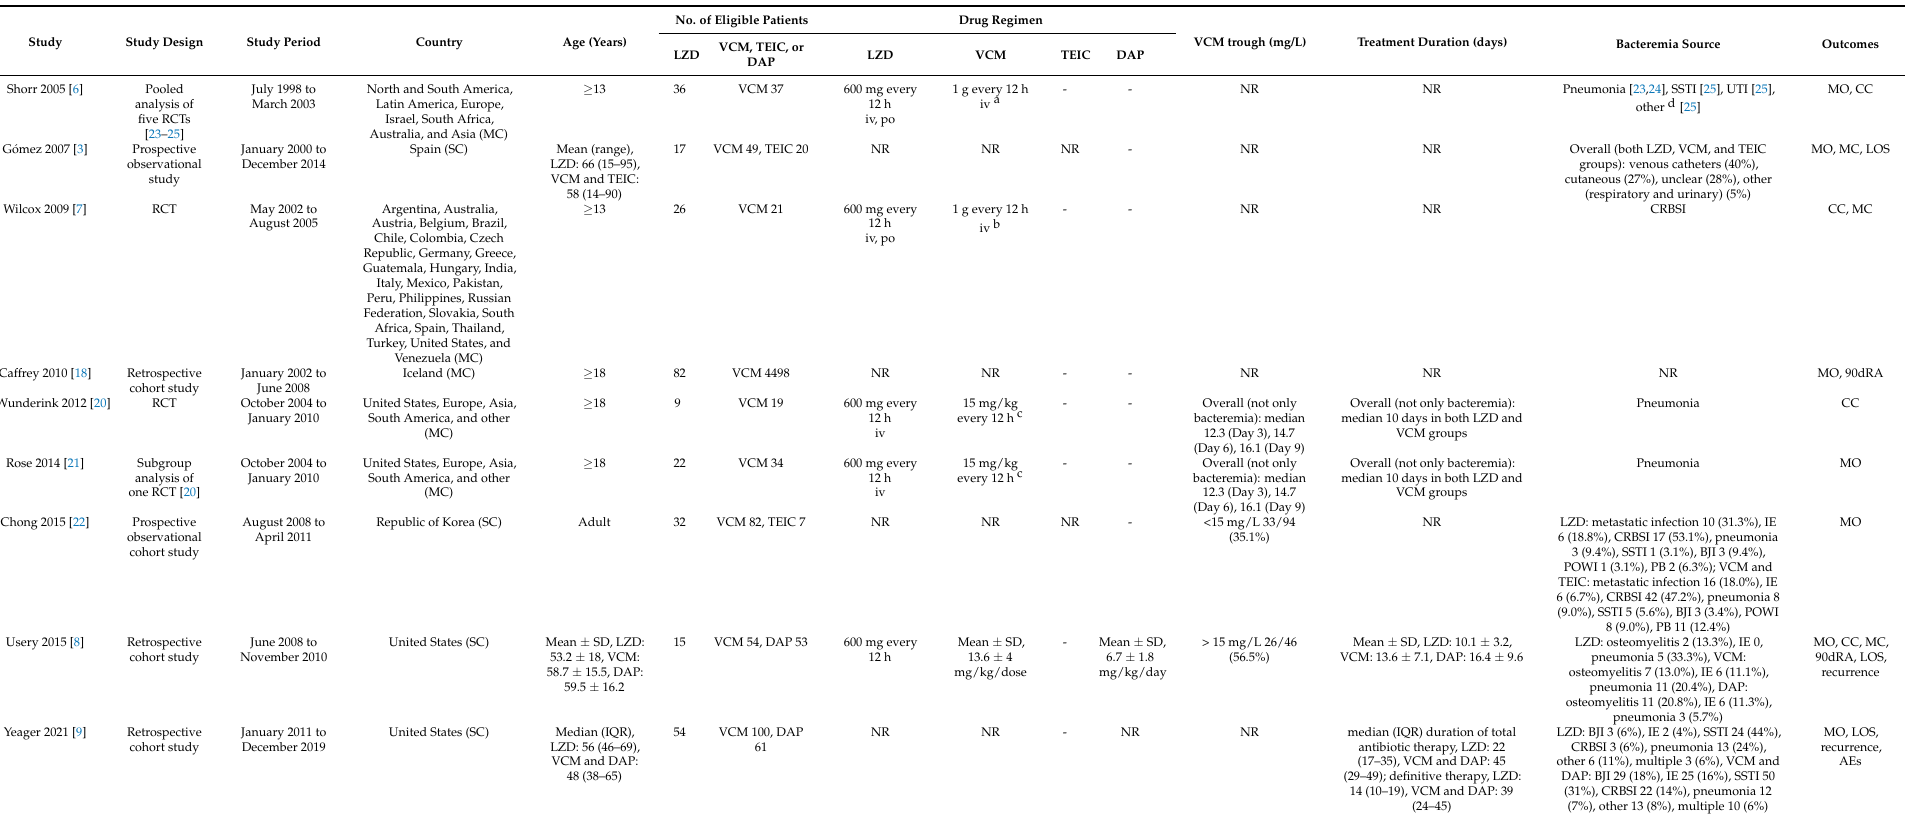
Table 1. Characteristics of studies included in the